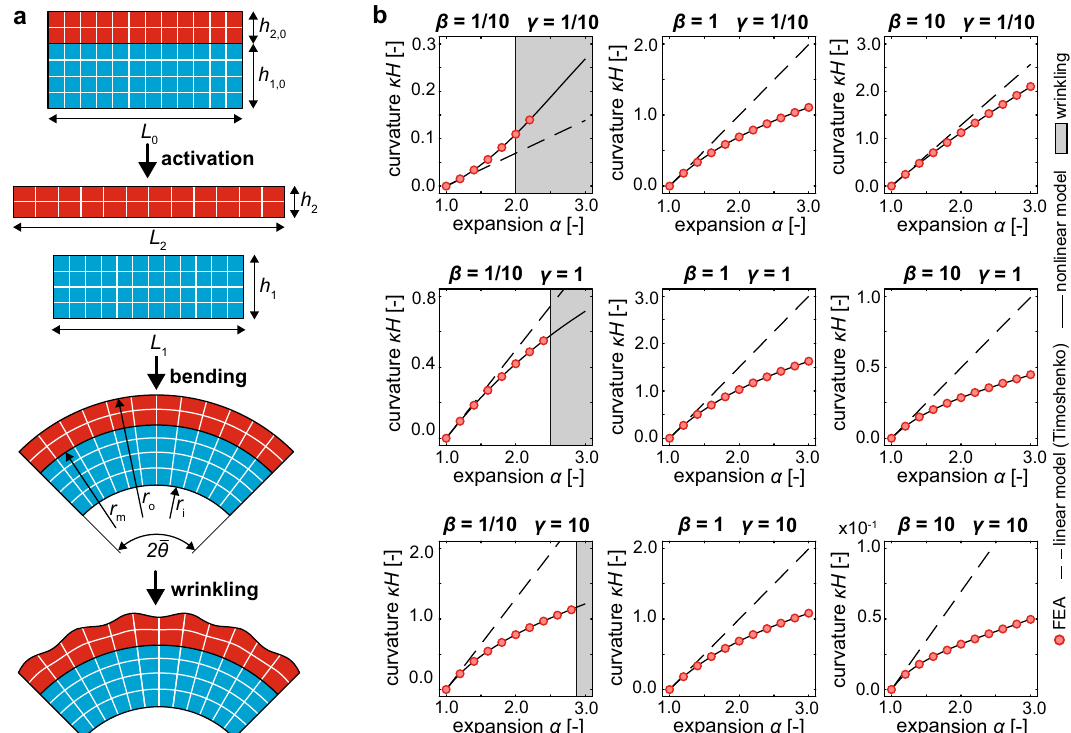
Fig. 2 Bending and wrinkling analysis of self-folding bilayers. a A schematic illustration of the folding and wrinkling of a bilayer element. b Theoretical and FEA results for bilayers with varying thickness ratio, β , and stiffness ratio, γ .